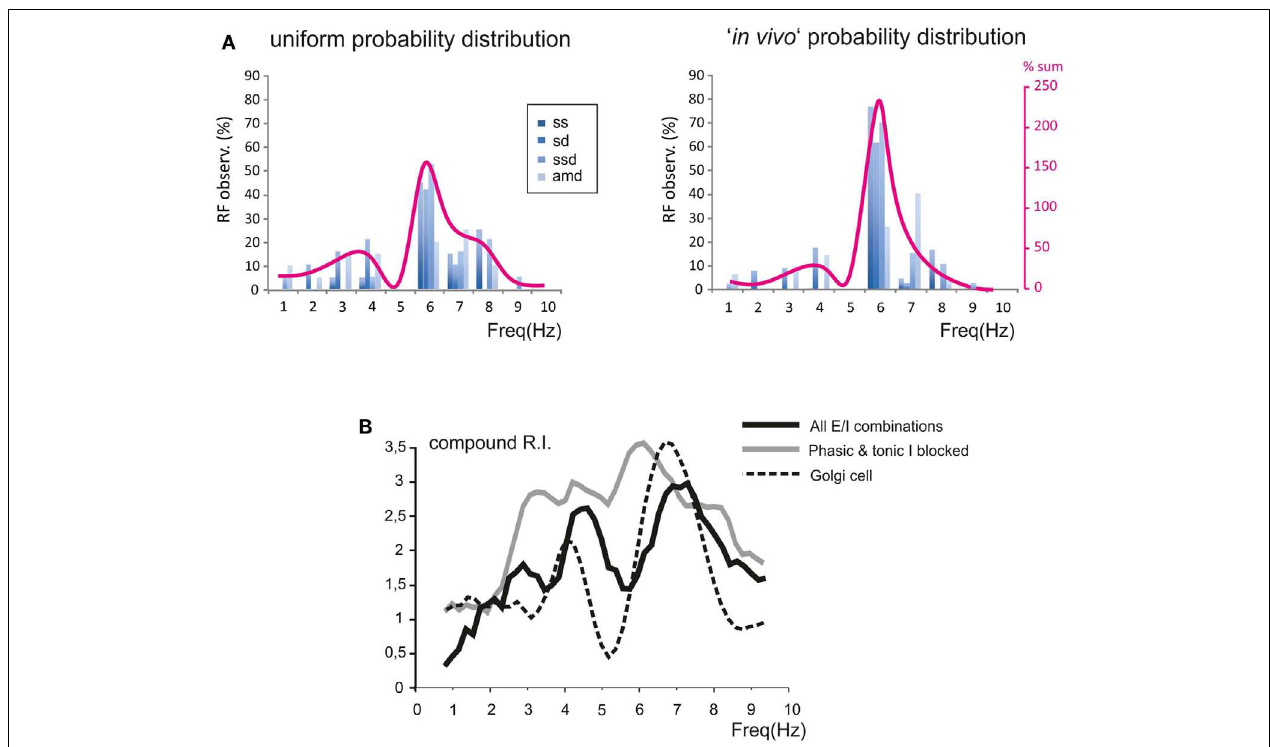
of E / I combinations. In the plot on the right we assumed the probability E / I distribution derived from Diwakar et al. (2011) in vivo . (B) The plot shows the compound RI calculated from model simulations using the E / I distribution derived from Diwakar et al. (2011) either including all E/I combinations (black trace) or with phasic and tonic inhibition blocked (gray trace; gabazine effect). Note the similarity of RI plots to those observed experimentally.The compound RI of a Golgi cell in the network (dashed trace) shows a major peak at 6–7Hz, explaining why inhibition block enhances RI at the same